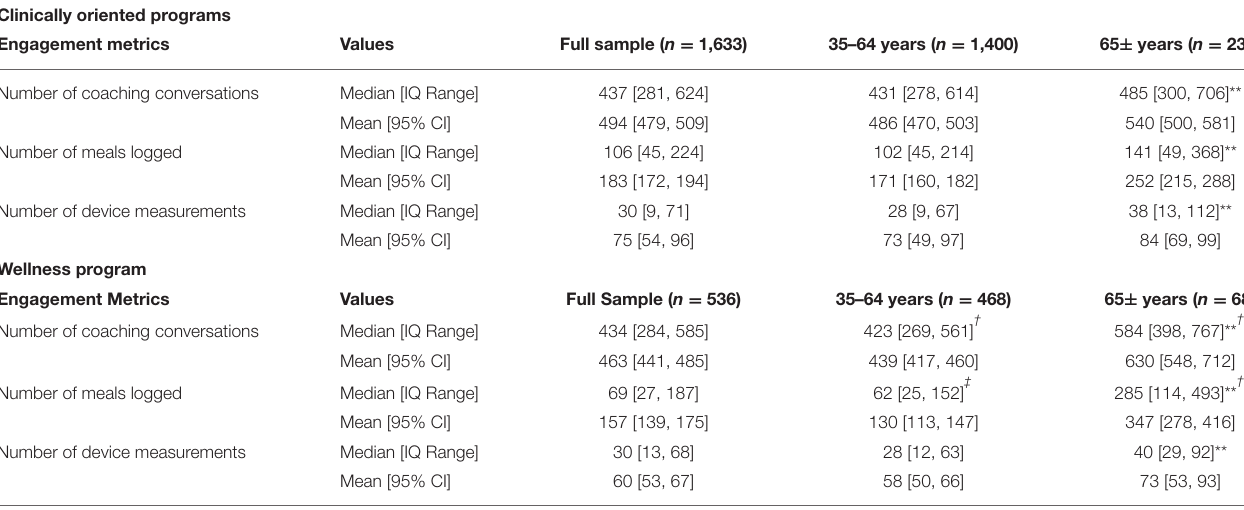
TABLE 3 | Engagement metrics of users over a 12-month period broken down by program-specific grouping into clinically oriented (diabetes prevention, diabetes care, and hypertension care) and wellness (prevention). Clinically oriented